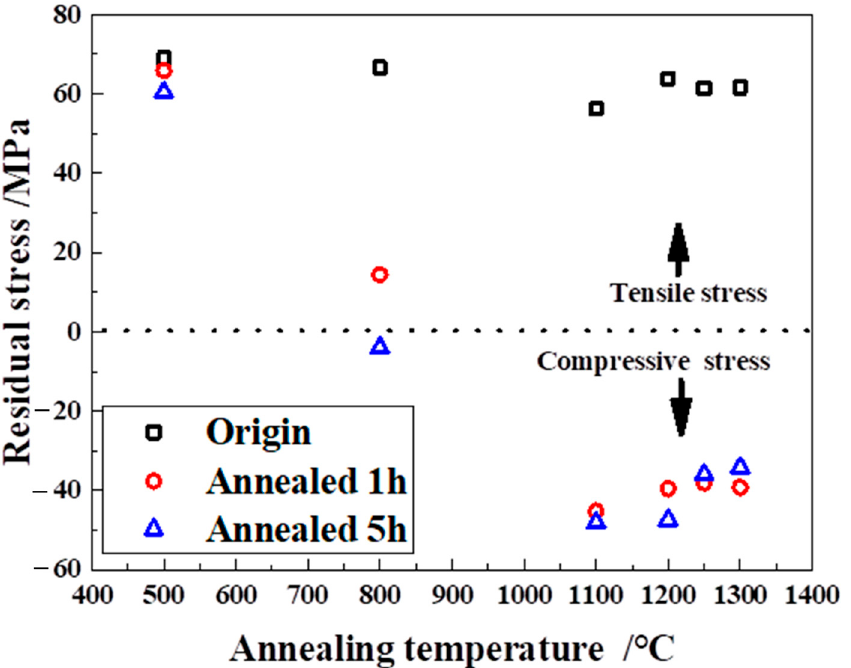
Figure 9. Residual stress (tested using the sin 2 ψ method) variations with differences in annealing temperatures and times.